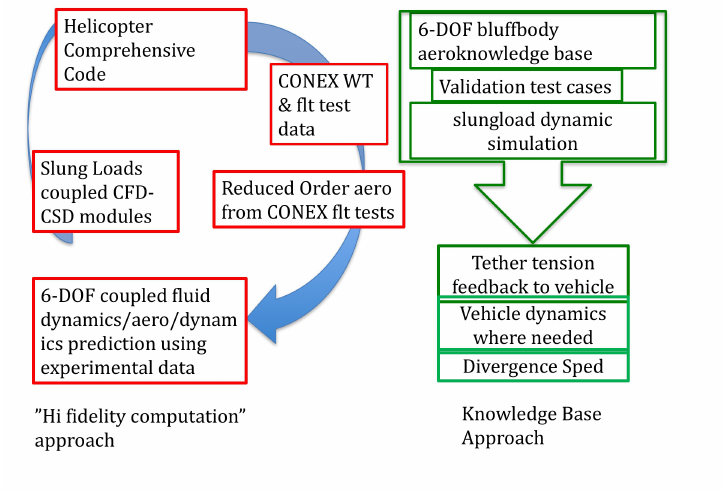
Figure 2. Comparison of approaches to certify the maximum safe speed of a vehicle with slung load. From [100] by permission of